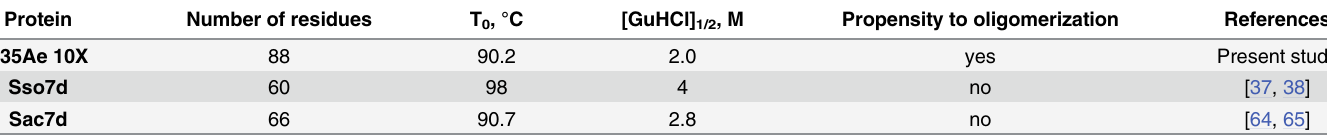
Table 5. Comparison of structural features of L35Ae 10X, Sso7d and Sac7d proteins (see Table 2). Protein Number of